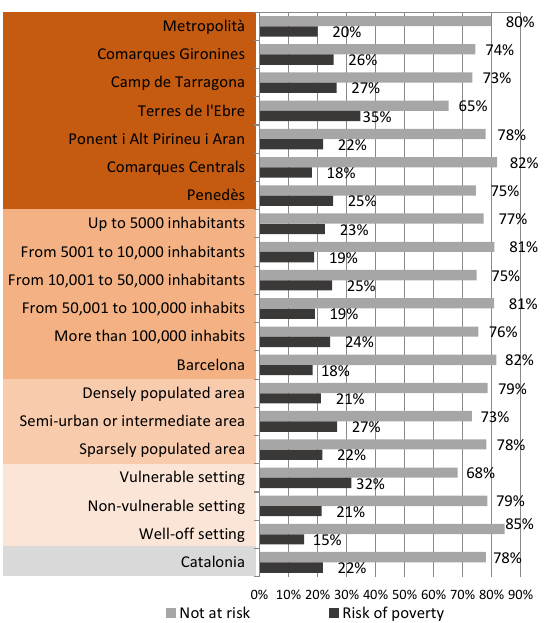
Figure 4. Levels of risk of poverty. Percentage of population resident in consumption units with incomes lower than 60% of the mean. Catalonia, 2011. Source: In-house construction based on the ECVHP, 2011.